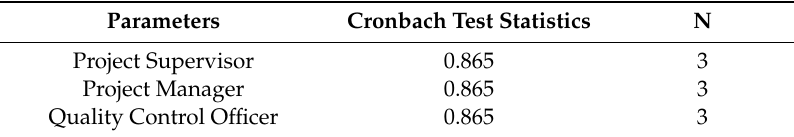
Table 17. Cronbach alpha reliability statistical test results.